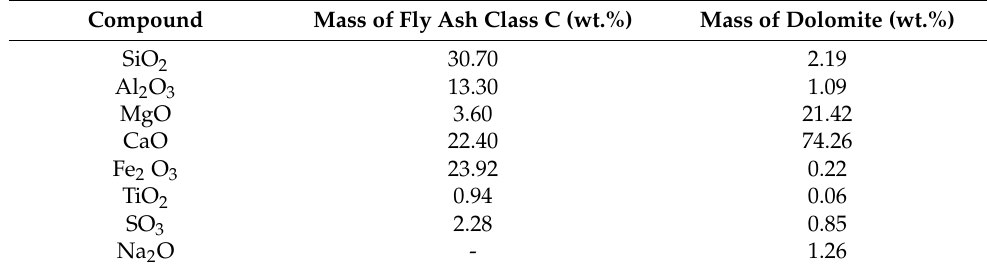
Table 1. The composition of fly ash class C and Dolomite. Compound Mass of Fly Ash Class C